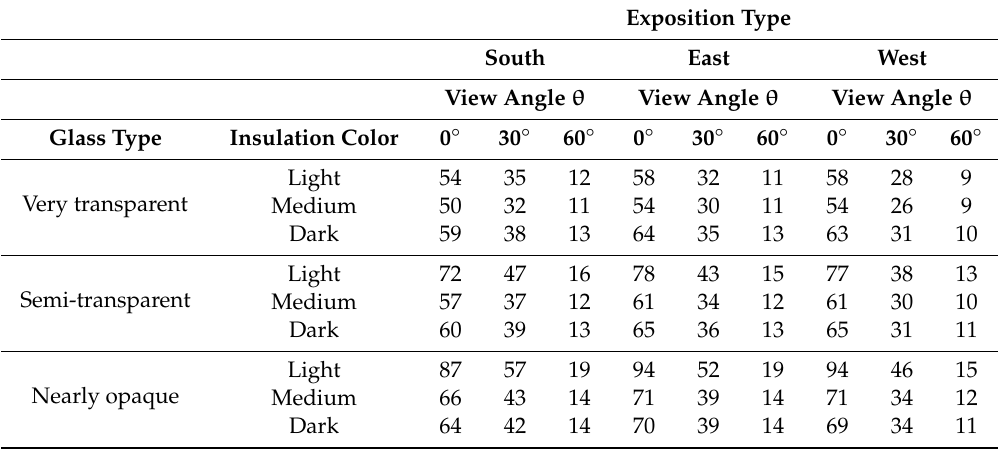
Table 6. Maximum thermal stresses (MPa) for New York.